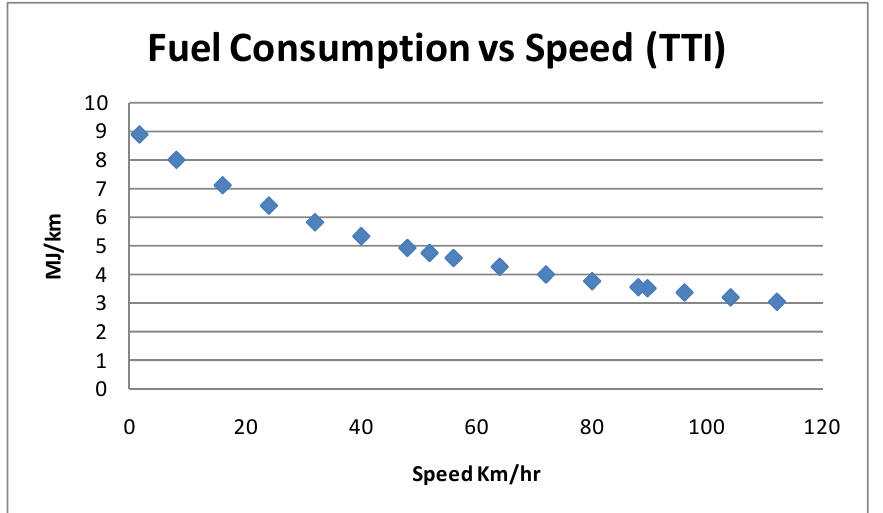
Figure 2. TTI Fuel Consumption vs .